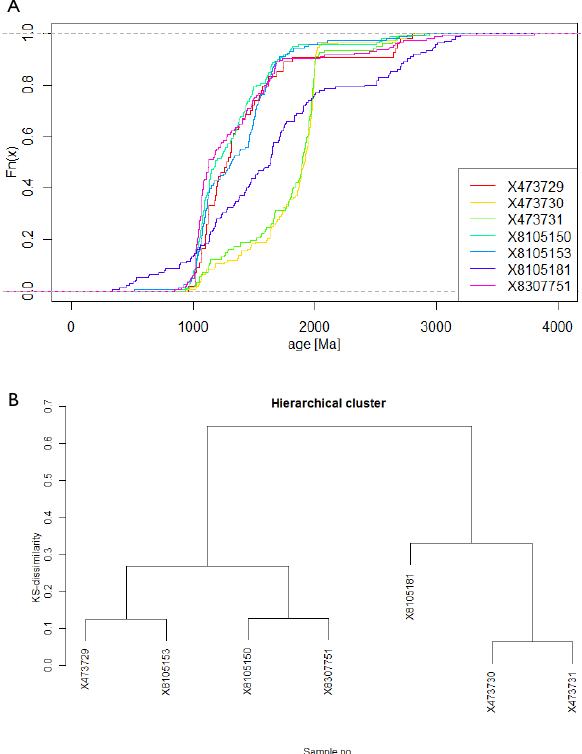
Fig. 4. Kolmogorov-Smirnov (KS) dissimilarities of the seven selected samples. A : Cumulative age distributions. B : Hierarchical clustering.